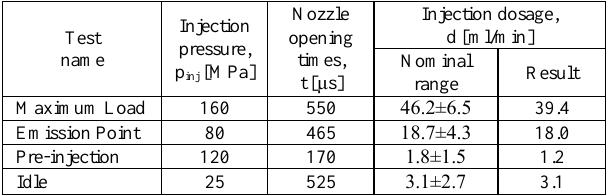
Table 2. Results of the preliminary fuel injector flow test